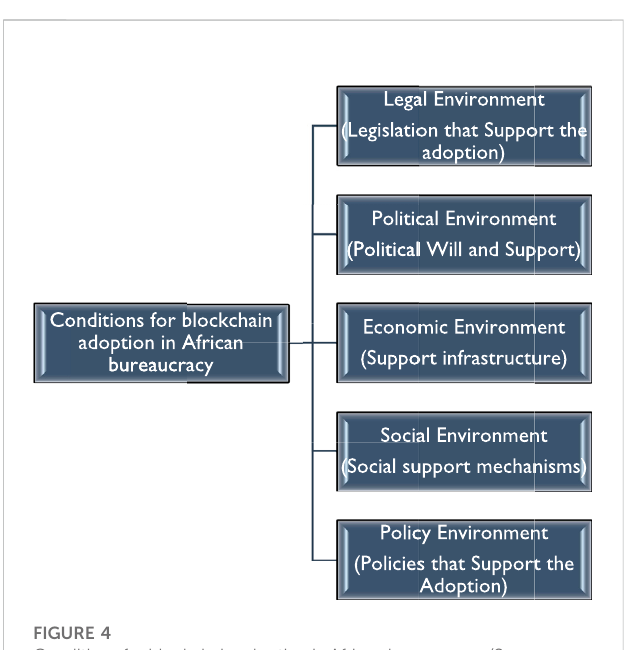
FIGURE 4 ConditionsforblockchainadoptioninAfricanbureaucracy(Source, Authors: 2022).